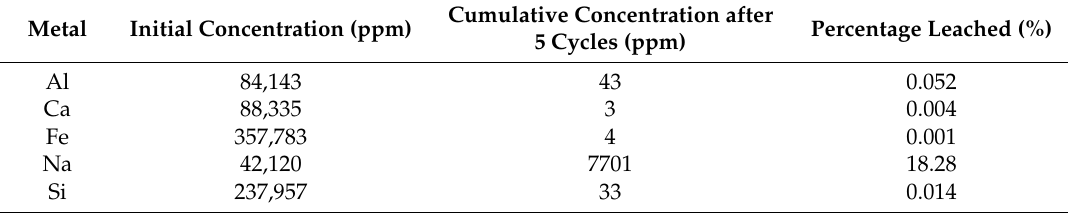
Table 7. Percentage leached out of metals with respect to initial